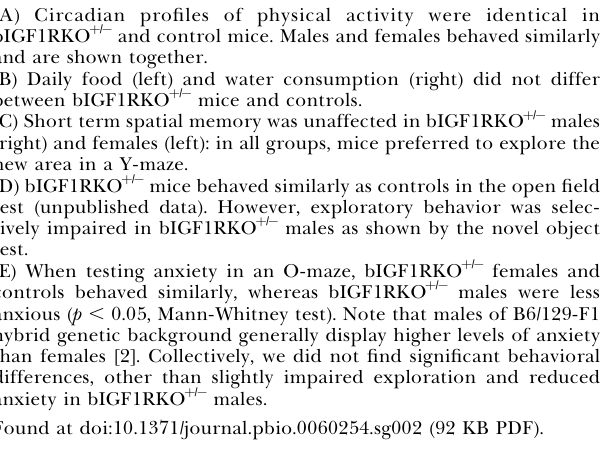
Figure S2. Activity, Nutrition, and Behavioral Analysis